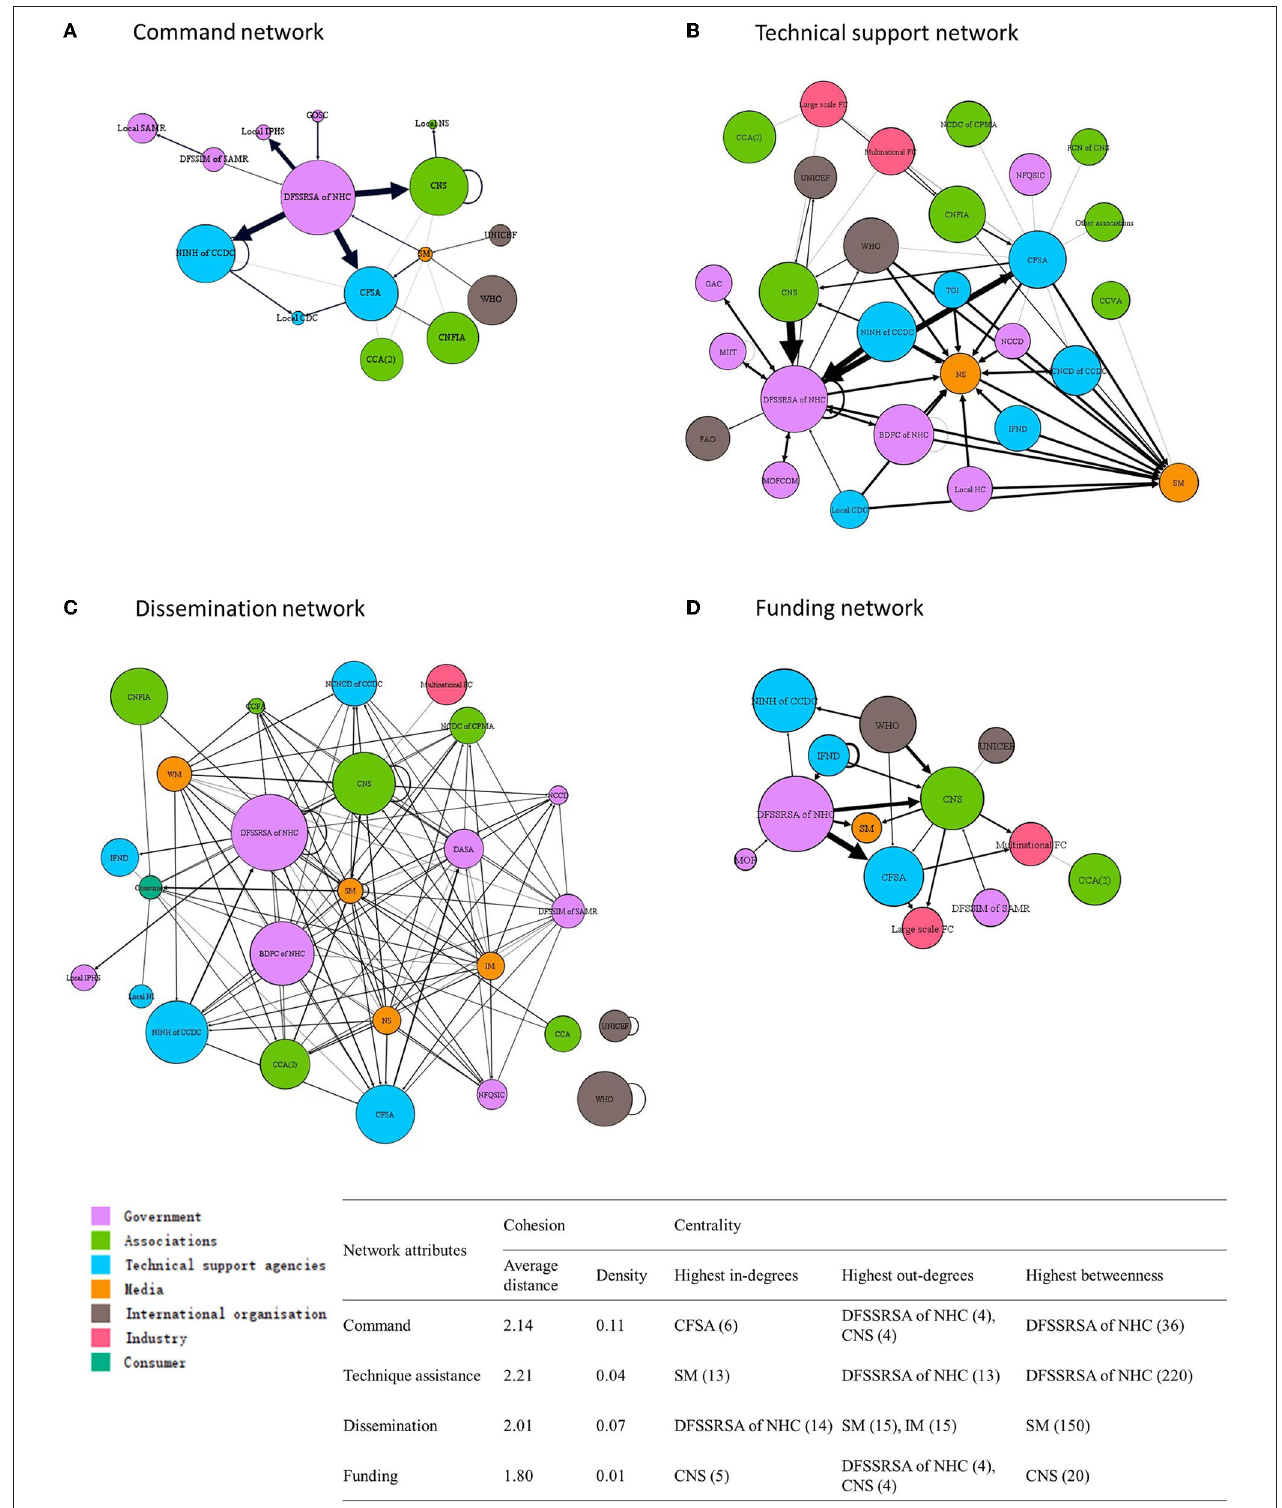
FIGURE 2 | Networks of actors for FoP labeling policy and programming in China regarding to (A) command, (B) technical support, (C) dissemination, and (D) funding. Nodes are sized by weighted average influence and colored by actor groups. Width of lines between nodes indicates the strength of links.